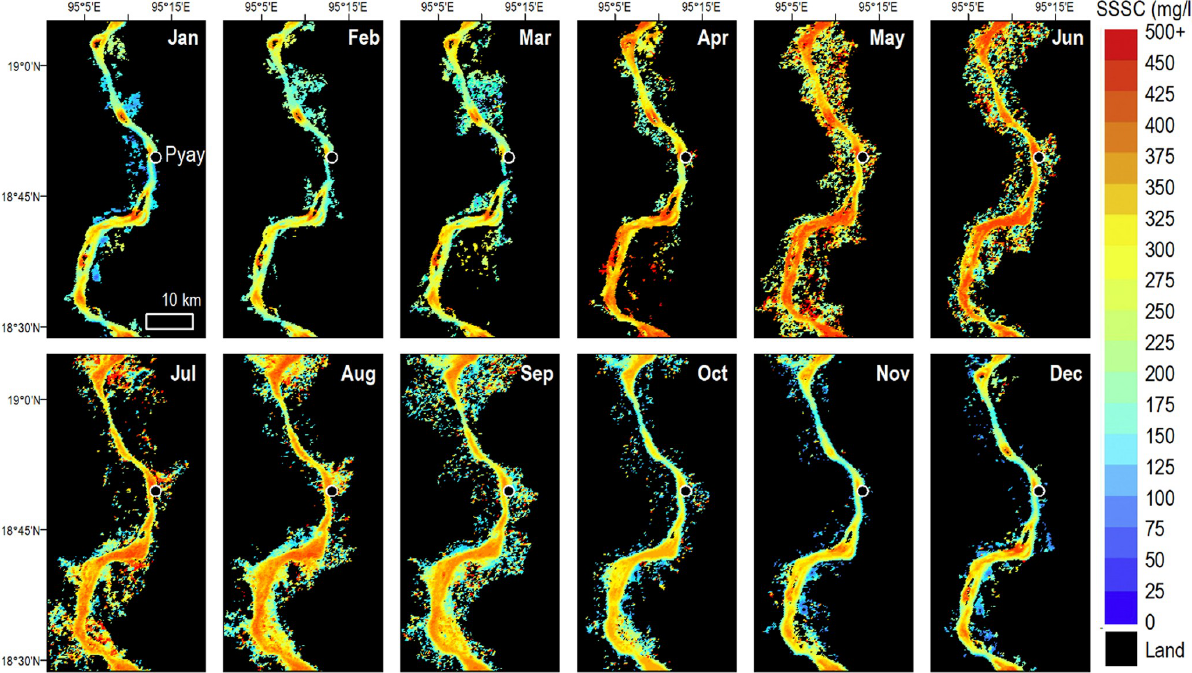
PLOS ONE | https://doi.org/10.1371/journal.pone.0251156 May 13,